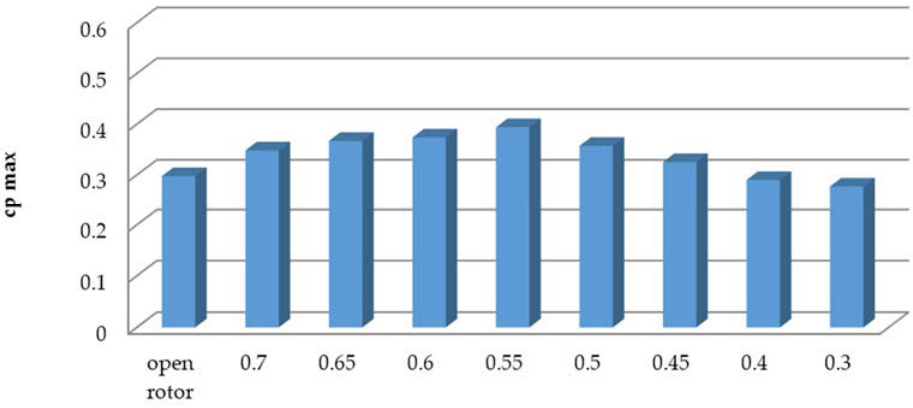
Figure 30. Variation of the maximum C p in different shape ratios.